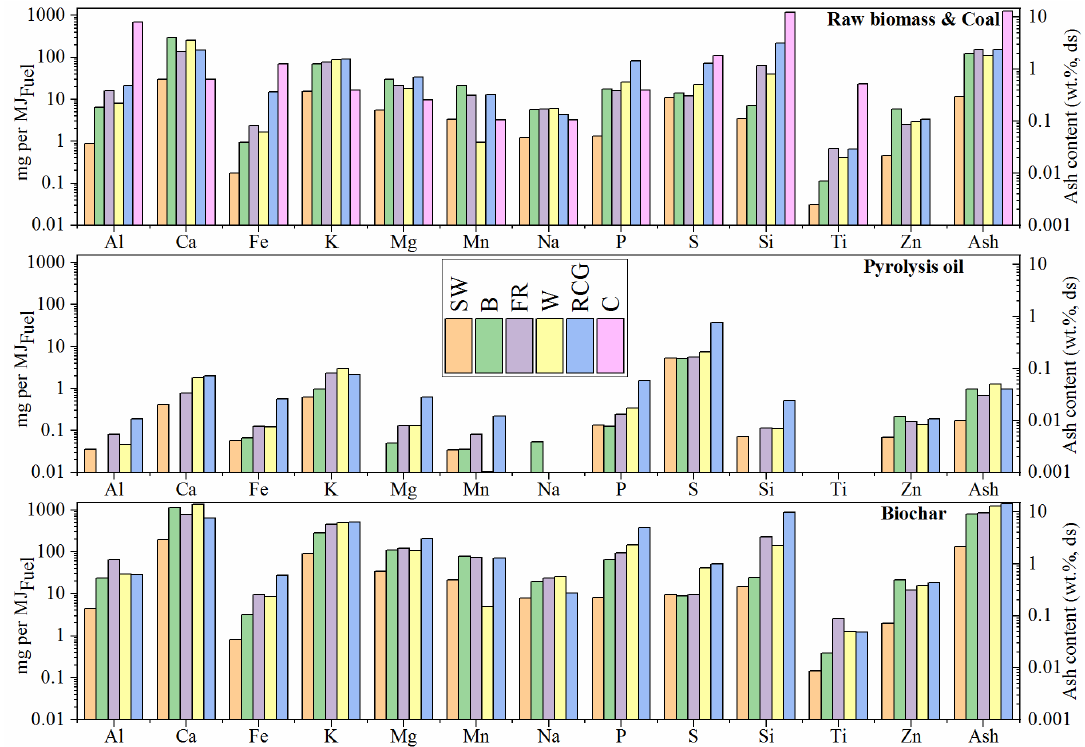
Figure 1. Mass distribution (mg / MJ Fuel ) of the inorganic elements in the investigated biomasses. SW, B, FR, W, RCG, and C stand for stem wood, bark, forest residue, willow, reed canary grass, and coal.